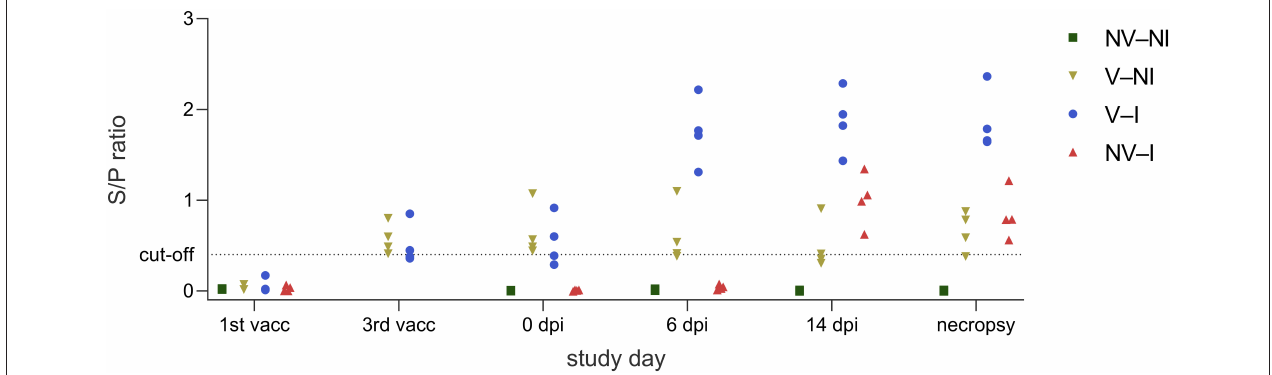
FIGURE 5 | Serological responses of gilts from the four treatment groups (NV–NI, non-vaccinated and non-infected; V–NI, vaccinated and non-infected; V–I, vaccinated and infected; NV–I, non-vaccinated and infected) at the timepoint of the first vaccination, third vaccination, 0 dpi, 6 dpi, 14 dpi, and on the day of necropsy, presented as an aligned dot plot. In contrast to the other timepoints, only V–NI and V–I gilts were examined on the day of the third vaccination. The ELISA was considered positive at an S/P ratio of ≥ 0.4.